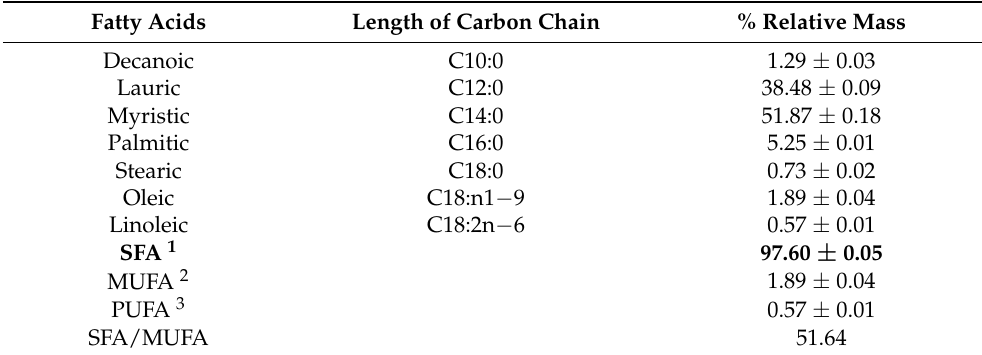
Table 4. Fatty acid profile of I. gabonensis